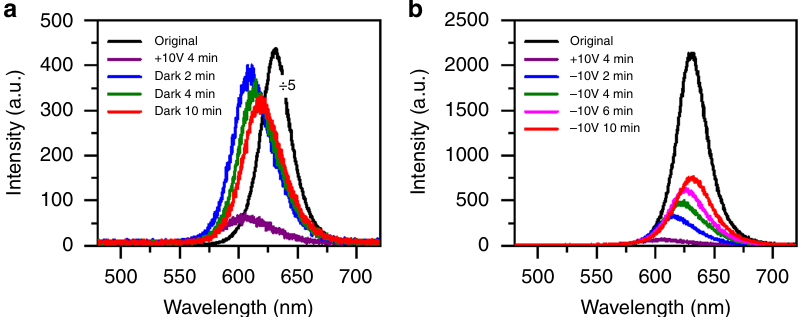
Fig. 3 Phase segregation in ensemble fi lm of CsPbBr 1.2 I 1.8 nanocrystals (NCs) under electrical biasing. a Original photoluminescence (PL) spectrum measured for one position of the ensemble fi lm without electrical biasing, together with the PL spectrum of this position measured after the ensemble fi lm had been electrically biased for 4 min at 10 V in the dark. Also shown are three PL spectra of this position measured after the electrical biasing had then been removed for 2, 4, and 10 min. b Original PL spectrum measured for one position of the ensemble fi lm without electrical biasing, together with the PL spectrum of this position measured after the ensemble fi lm had been electrically biased for 4 min at 10 V in the dark. Also shown are four PL spectra of this position measured after a reverse electrical biasing of 10 V had been continuously supplied in the dark for 2, 4, 6, and 10 min. To acquire each of the PL spectra shown in a and b , the laser beam was unblocked for 1 s to excite the ensemble fi lm with a power density of 6 W cm −